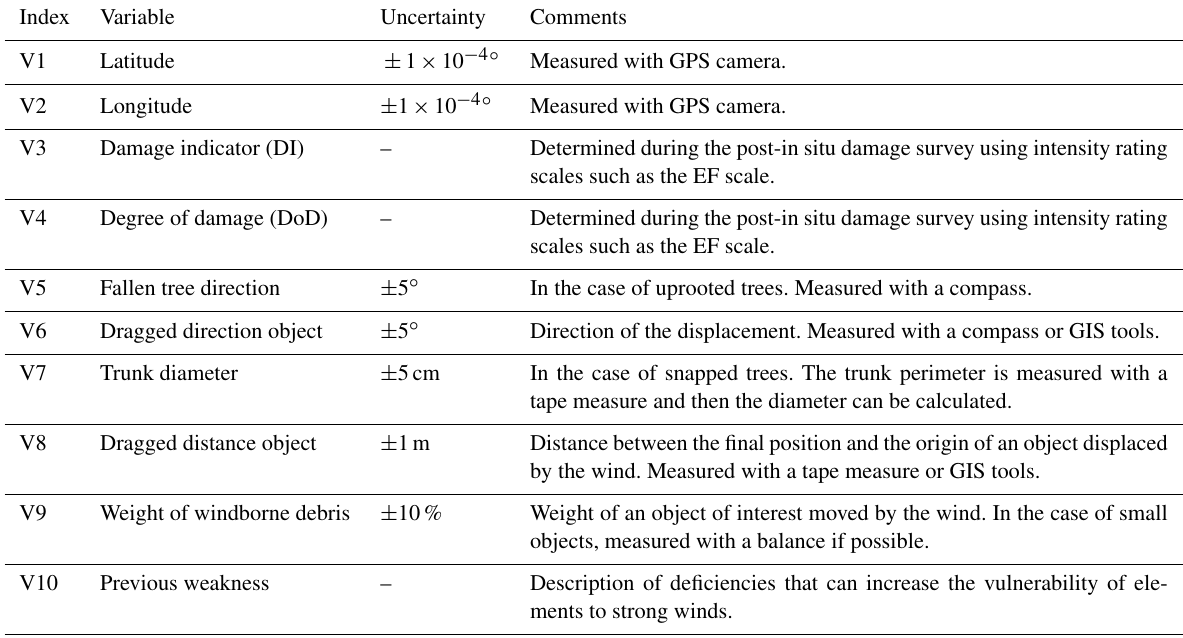
Table 2. Variables and maximum uncertainties recommended for data descriptors for damaged human-made structures and vegetation el- ements. The first four variables are required for all damaged elements (both human-made structures and vegetation). Dragged distance, direction and weight of windborne debris should be measured if possible for relevant and representative elements (e.g. fragment of panel roof). Fallen tree direction and trunk diameter should be measured in the case of uprooted and snapped trees, respectively. Degraded state or previous weakness of damaged elements should also be